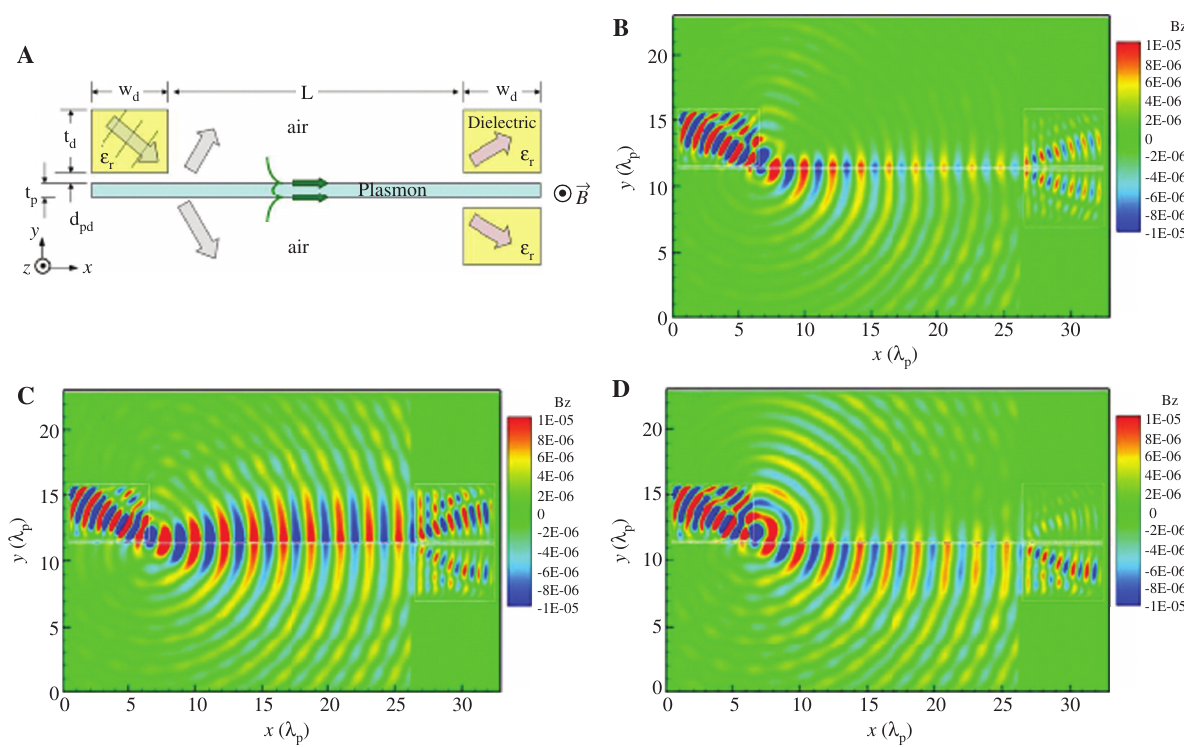
= 0.5 ω (from [64]). (A) Schematic structure of the long-range SMPs wave- c p